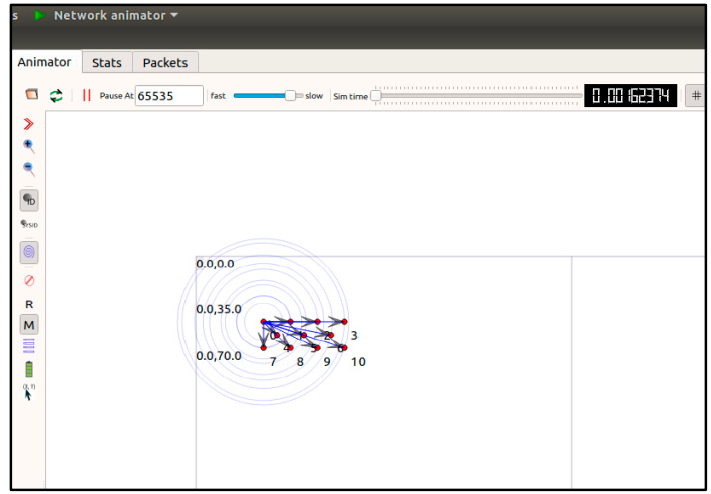
Figure 19. V2V secure group communication simulation in NS-3.